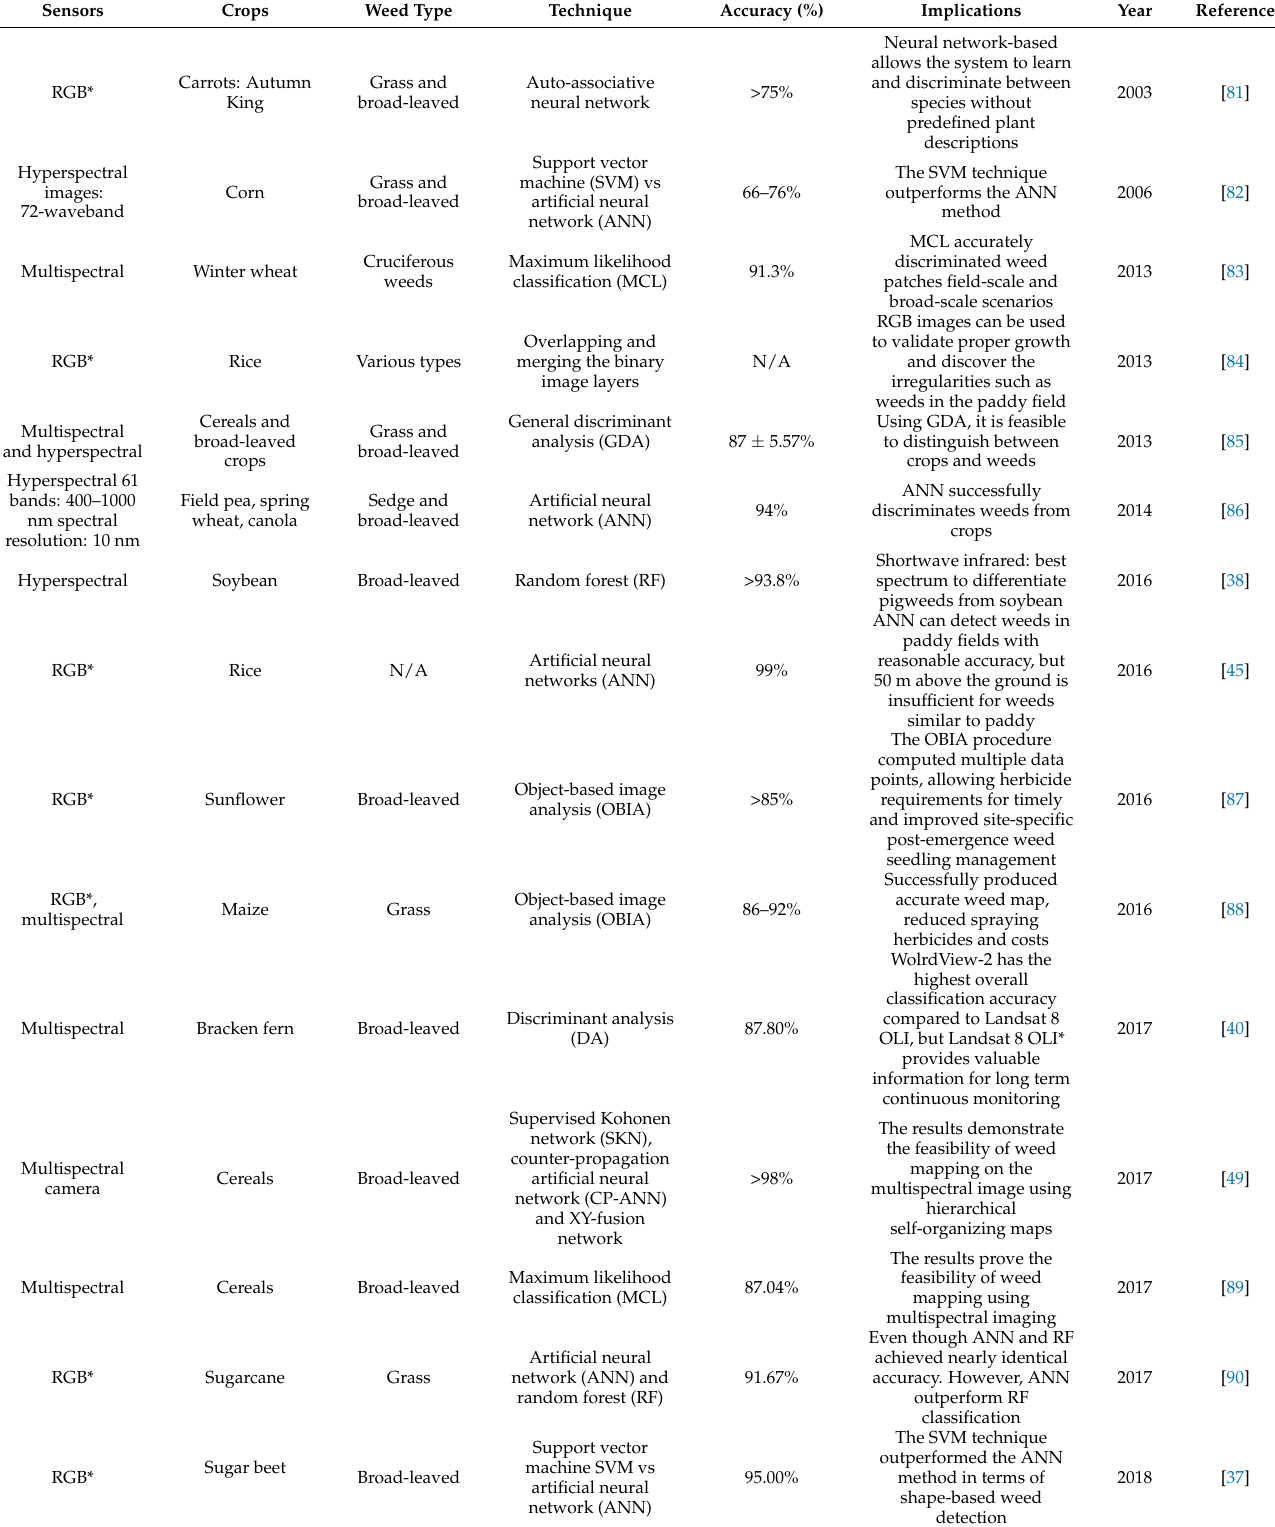
Table 4. Weed detection and mapping in various crops that apply remote sensing